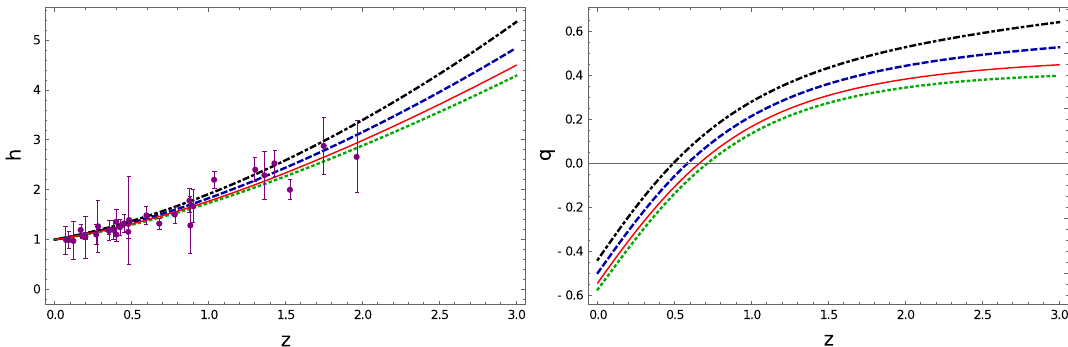
Fig. 3 The evolution of the Hubble parameter (left panel) and of the deceleration parameter (right panel) as a function of the redshift in the exponential case φ( z ) = exp ( 2 δ z ) . The dashed, dotted and dot-dashed